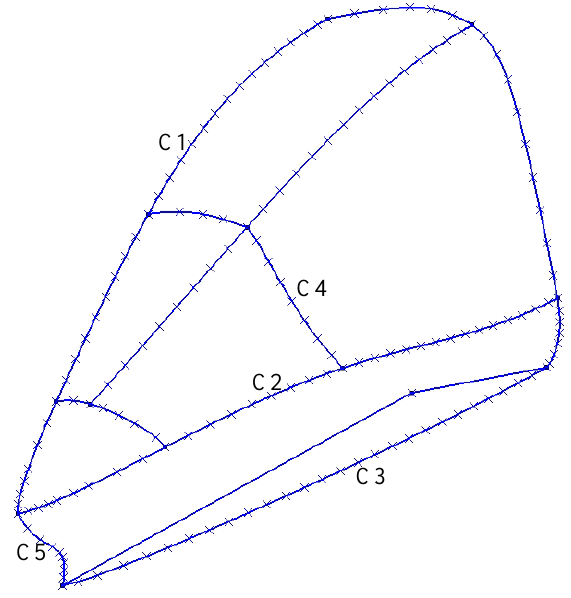
Figure 2. Left half of streamlined head.